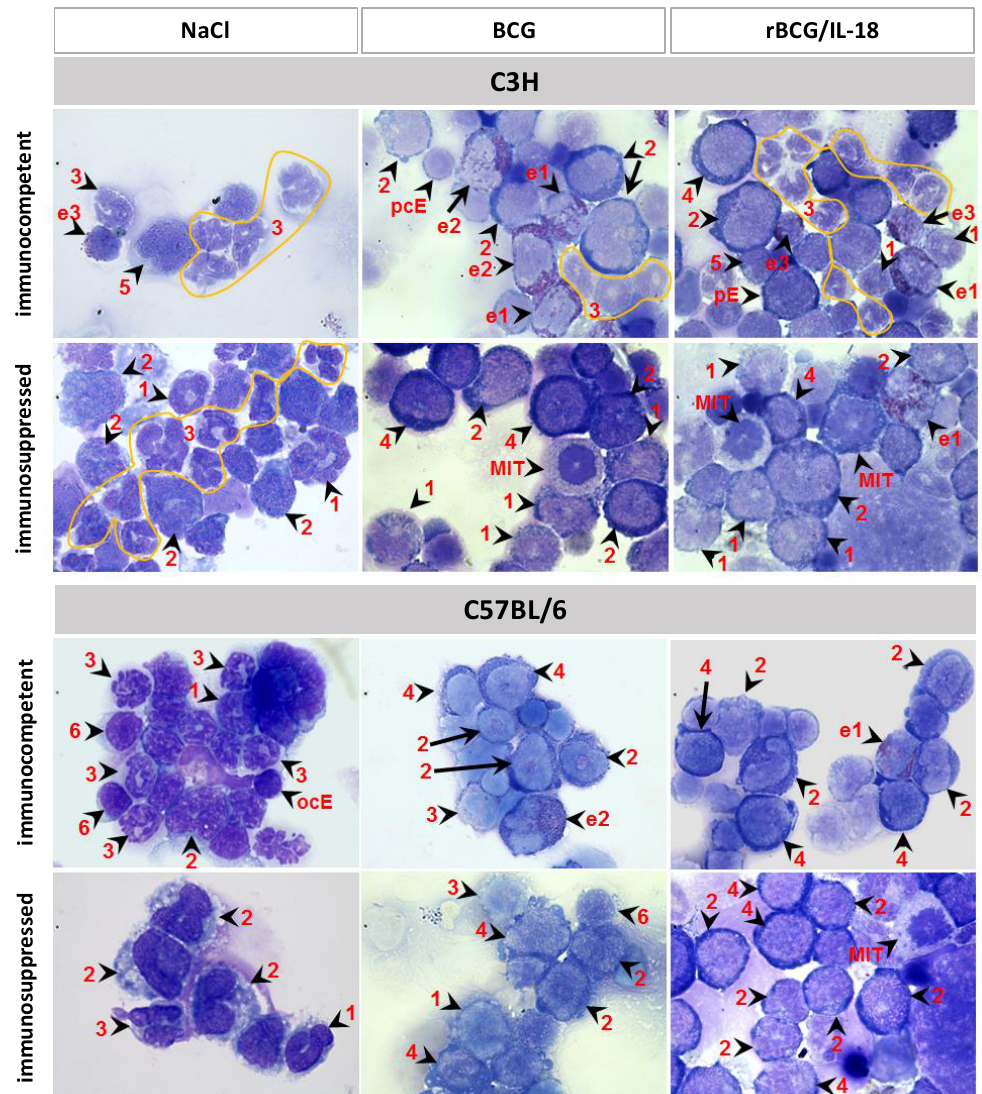
Figure 1. Morphology of bone marrow cells isolated from C3H and C57BL/6 mice who had been immunocompromised with cyclophosphamide or immunocompetent animals who had been injected with physiological saline (NaCl) and immunized with Mycobacterium bovis (wild-type BCG) or the recombinant BCG (rBCG) strain secreting interleukin (IL)-18. Representative pictures are shown for each group. Cytospins were prepared from freshly isolated bone marrow and stained with the May–Grünwald for 6 min and Giemsa solution for another 15 min. Finally, the slides were rinsed with water and placed to dry in air. The cells were observed using a light microscope at 100 × magnification (immersion). The experiment was triplicated, and each time, at least 12 randomly selected view fields per slide were captured. The cells were identified on the basis of histological/morphological markers by two independent histopathologists from Institut für Tierpathologie, Berlin, Germany, and are indicated by arrows and numbers: (1) myelocyte, (2) promyelocyte, (3) metamyelocyte, (4) myeloblast, (5) monocyte, (6) lymphocyte, (e1) eosinophilic myelocyte, (e2) eosinophilic promyelocyte, (e3) eosinophilic metamyelocyte, (MIT) mitosis, (pE) proerythroblast, (pcE) polychromatic erythroblast, and (ocE) orthochromatic erythroblast.